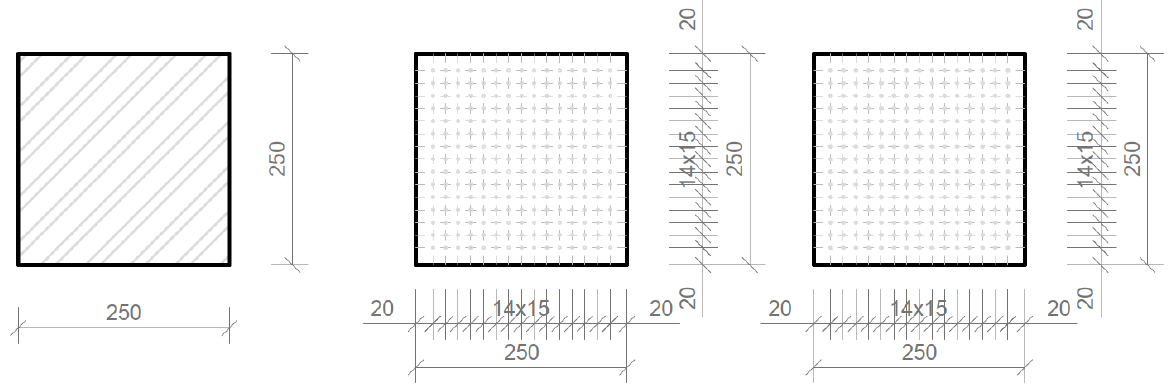
Figure 9. Drawings of individual slabs.